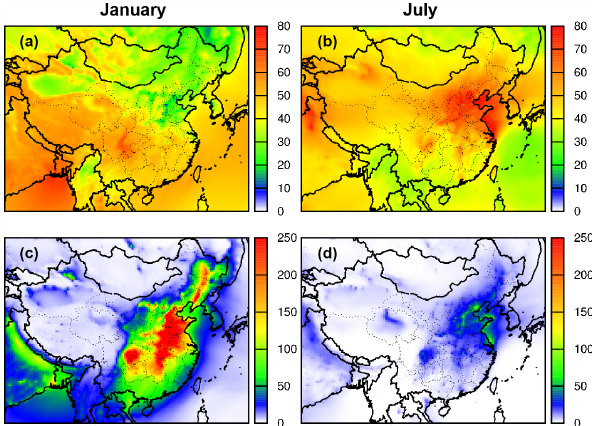
Figure 3. Changes in monthly average O 3 -8h (ppb) in January and July 2013 due to (a) T + 1 . 0K, (b) WS − 10%, (c) AH + 10%, (d) PBLH − 20%, (e) CLW + 10%, and (f) PCP +